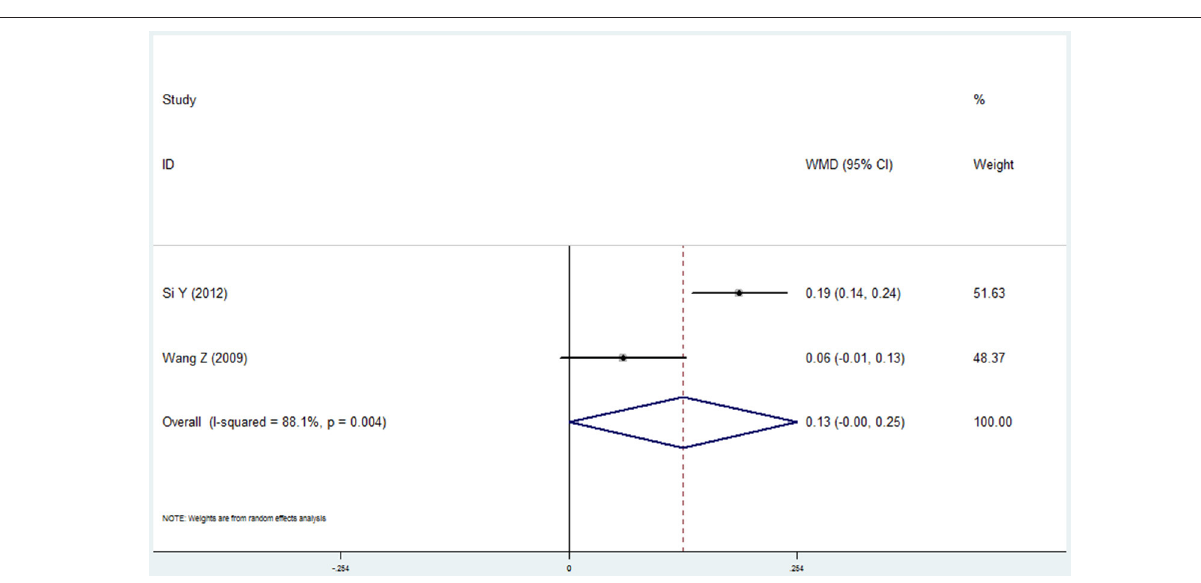
FIGURE 4 | Forest plot of the mean difference in level of alveolar bone loss between the COPD and non-COPD